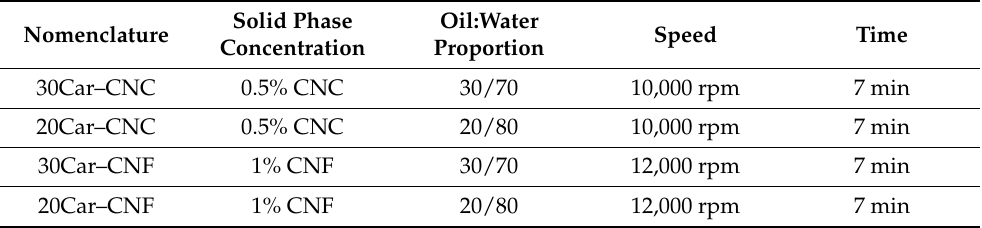
Table 1. Adopted nomenclatures of the prepared samples, considering their preparation methodolo- gies and conditions: nanocellulose concentration, oil:water proportion, speed, and